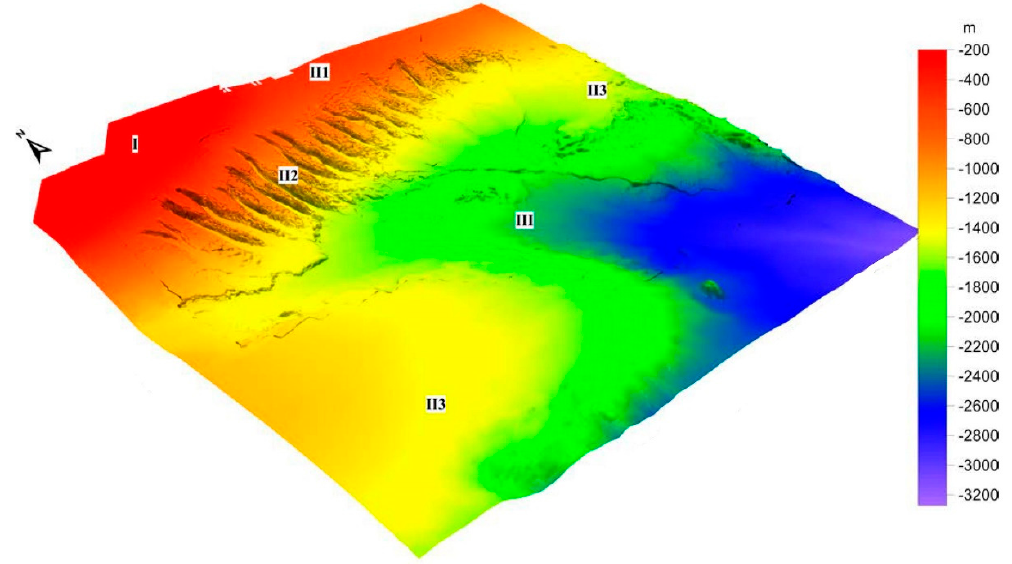
Figure 7. Multi-beam submarine geomorphology shadow map showing the head scarp of the Baiyun – Liwan submarine slide, where the migrating submarine canyons and the Baiyun slide developed on the head scarp of the Baiyun – Liwan submarine slide. I = continental shelf; II1 = upper continental slope; II2 = submarine canyons; II3 = lower continental slope; III = Baiyun slide.